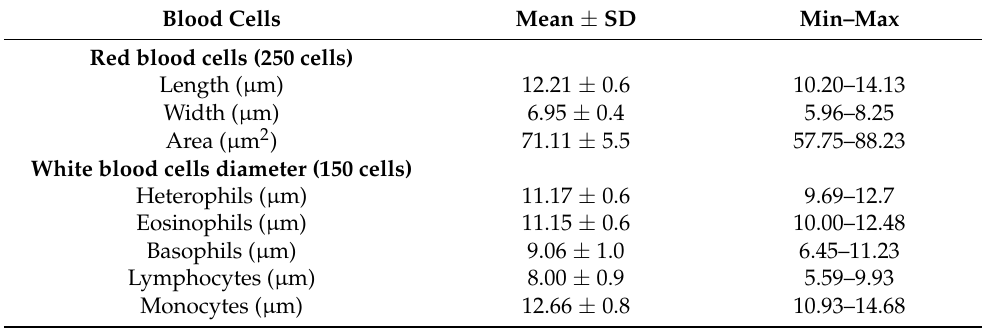
Table 3. Blood cells’ morphometry in non-parasitized rufous-winged